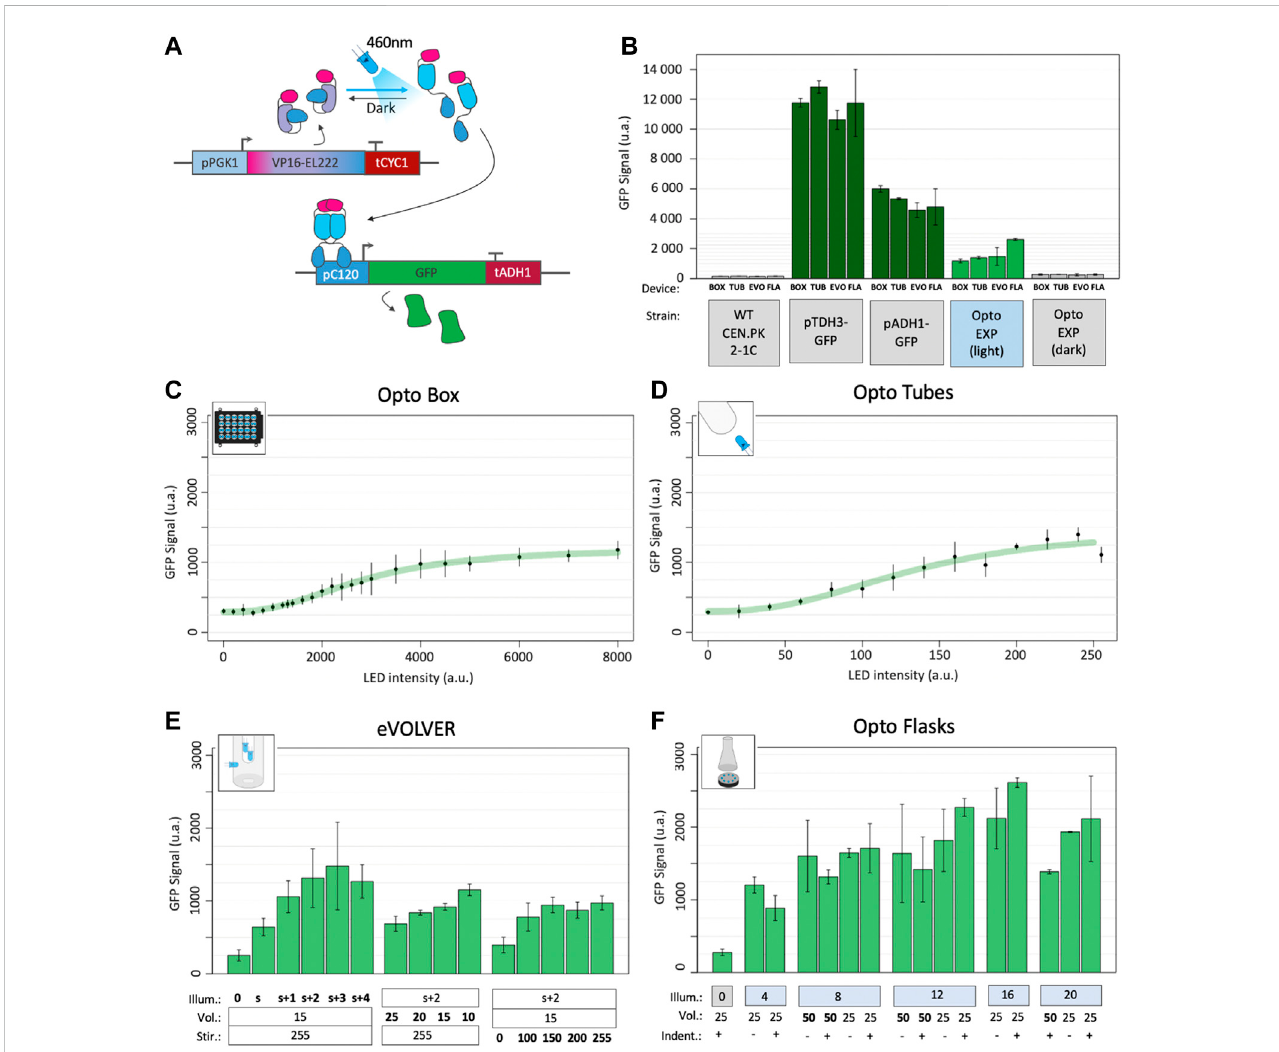
FIGURE 2 Optogeneticactivationindifferentdevices. (A) TheEL222optogeneticsystemrespondstobluelightwhichactivatesthetranscriptionofgenesunderthe control of the pC120 promoter (here a GFP, in the OPTO-EXP strain). Adapted from (Zhao et al., 2018). (B) Fluorescence GFP levels of the background strain CEN.PK2-1C; strains carrying GFP under the strong pTDH3 and medium pADH1 constitutive promoters; and highest levels of fl uorescence reached with the OPTO-EXP strain in the light and in the dark in each the four different illumination devices (BOX: OptoBox, TUB: OptoTubes, EVO: eVOLVER, FLA: OptoFlasks). (C) OPTO-EXP optogenetic activation in the OptoBox. Cumulative LED intensities from 0 to 8000 u.a. correspond to 0 – 4 mW/cm 2 per LED. (D) OPTO-EXP optogenetic activation in the OptoTubes. LED intensities from 0 to 255 u.a. correspond to 0 – 12 mW/cm 2 (Supplementary Figure S1) (E) OPTO- EXPoptogeneticactivationintheeVOLVER,withvariationofillumination(numberofLEDs:s+2correspondstotheside-LEDand2additionalLEDsinserted via thelid), volume (mL)and stirring (u.a., 0 – 255). The side-LEDcorrespondsto 6 mW/cm 2 ,and 1, 2, 3, and4 additionalLEDsadd 6.7, 8.3, 9,3 and 9.4 mW/cm 2 of intensity in the medium. (F) OPTO-EXP optogenetic activation in OptoFlasks. Illumination (0, 4, 8, 12, 16 or 20 LEDs on the illumination stand, 12 mW/cm